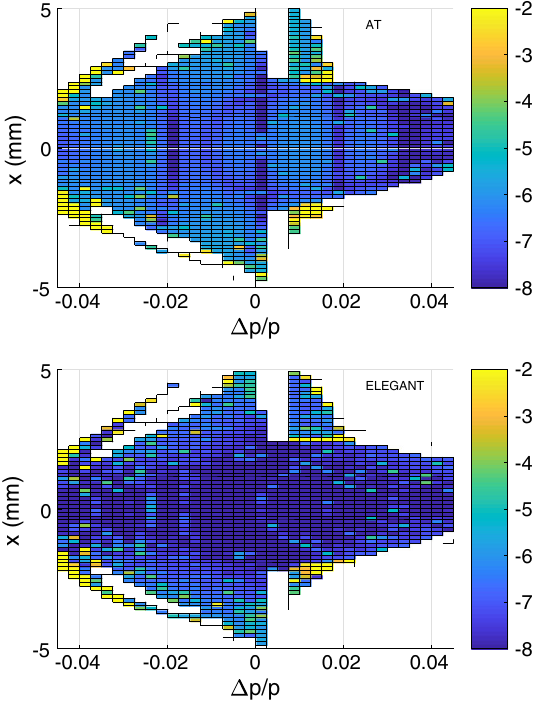
FIG. 9. Comparison of stability region in the x - Δ p calculated by AT (top) or ELEGANT (bottom). Color code represents tune diffusion as defined in Eq.